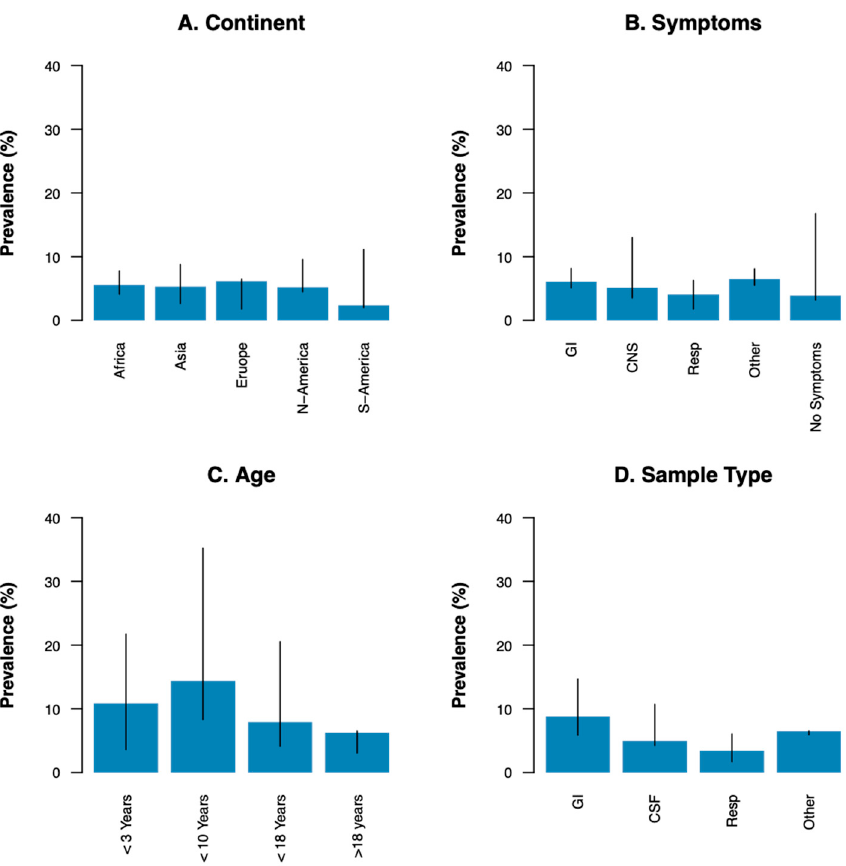
Figure 3. Weighted median prevalence of EVs by ( A ) Continent, ( B ) Sample type, ( C ) Symptoms of the participants and ( D ) Age of the participants. N-America; North America, S-America; South America, GI; gastrointestinal, Resp; respiratory, CNS; central nervous system, CSF; cerebrospinal fluid.